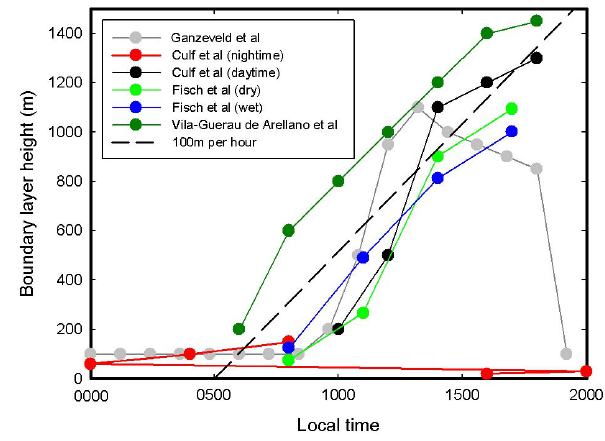
Fig. 1. A summary of previous experimental and theoretical results for the MLH above the tropical rain forest. The horizontal axis represents 20 hours of time starting at mid- night.